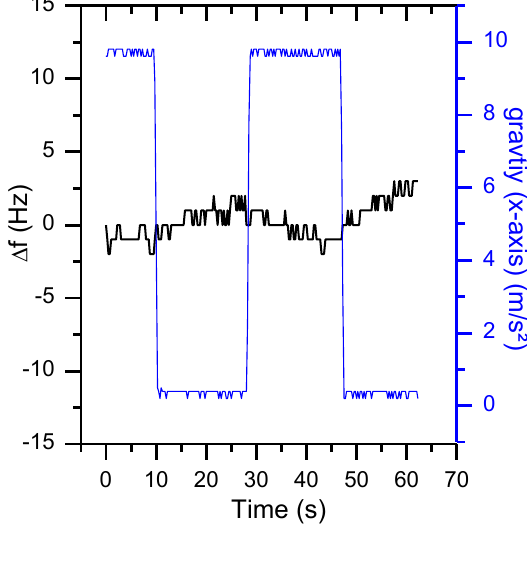
Figure 23. Frequency response of a 90° rotation with heat pipe at the